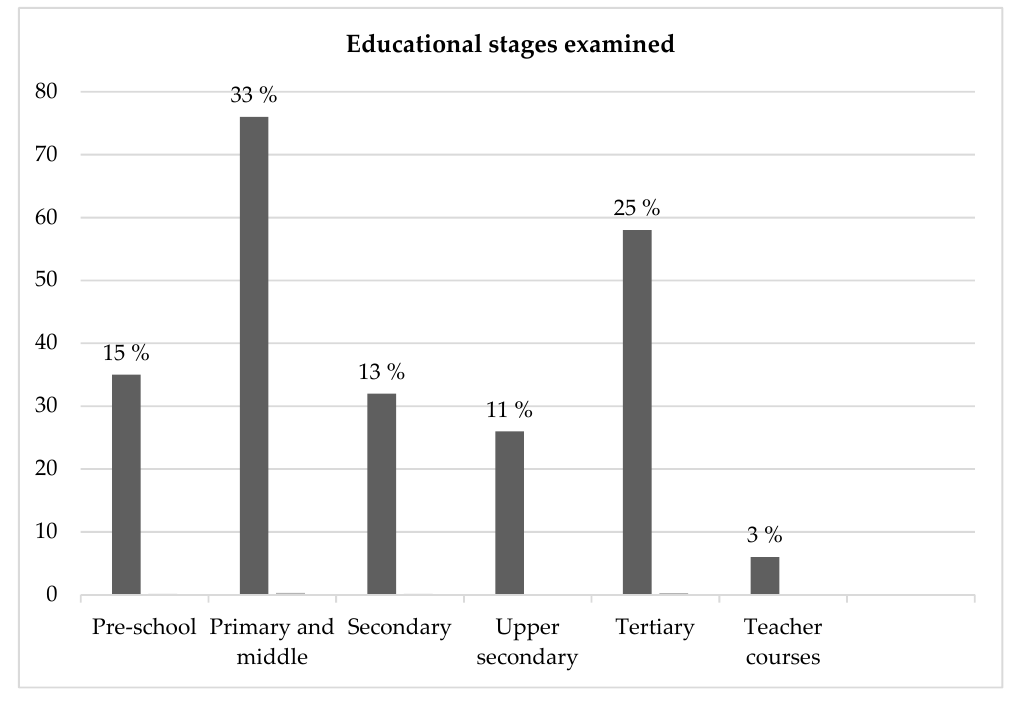
Figure 4. Educational stages examined.